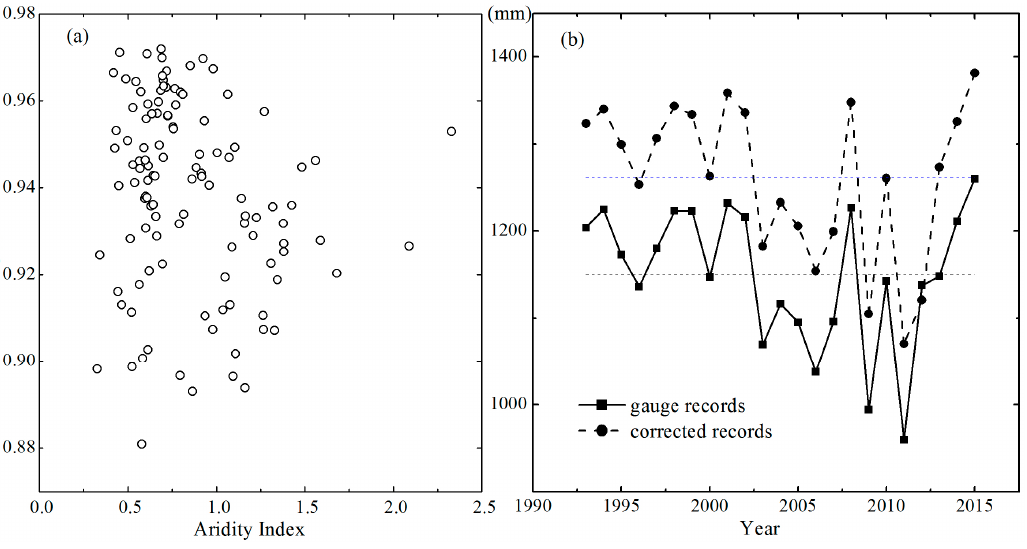
Figure 2. ( a ) Mean values of catch ratio ( CR ) of the gauge measured precipitation to the corrected precipitation in Southwest China and ( b ) the difference of gauge records with corrected records from 1993 to 2015.